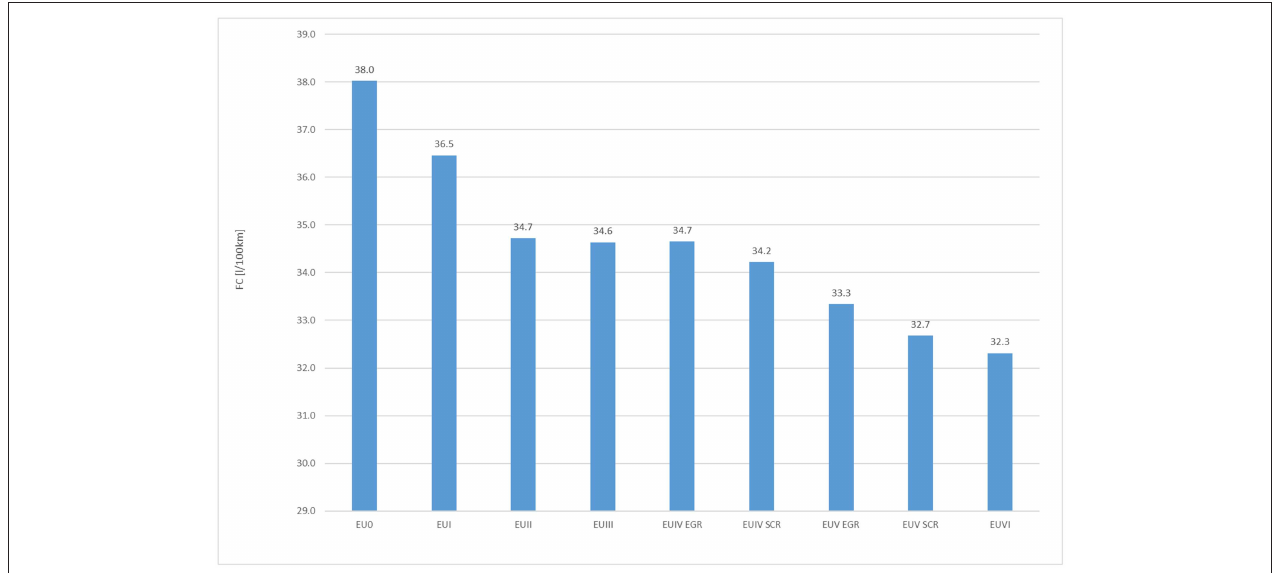
FIGURE 9 | Specific fuel consumption values of the HBEFA 4.1 depending on the vehicle generation for a tractor trailer on an average German motorway adapted from Matzer et al. (2019) with permission of TU Graz.